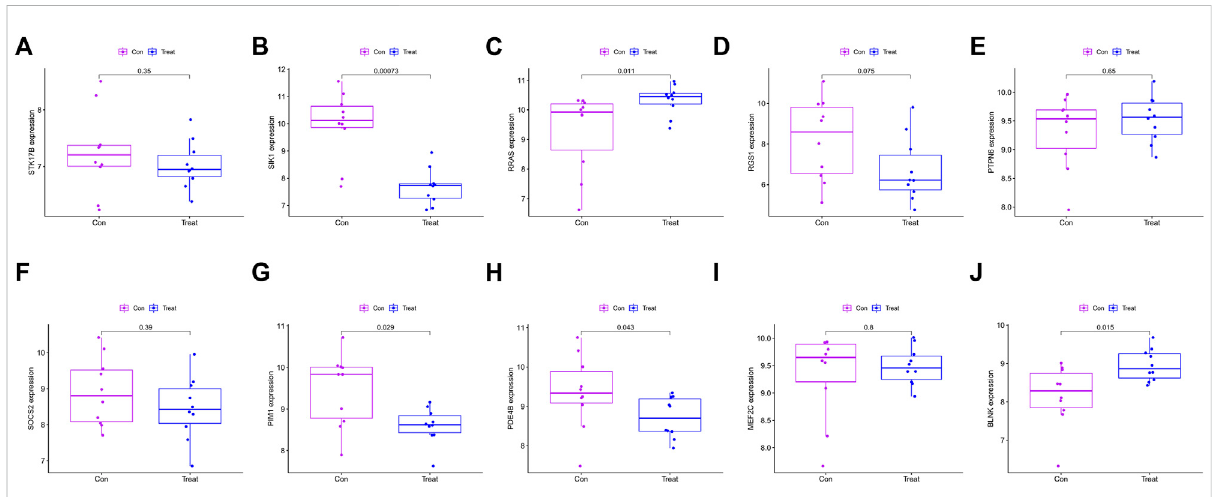
FIGURE 6 BoxplotshowingthedifferenceinexpressionofhubgenesinOAgroup (A) STK17B; (B) SIK1; (C) RRAS; (D) RGS1; (E) PTPN6; (F) SOCS2; (G) PIM1;